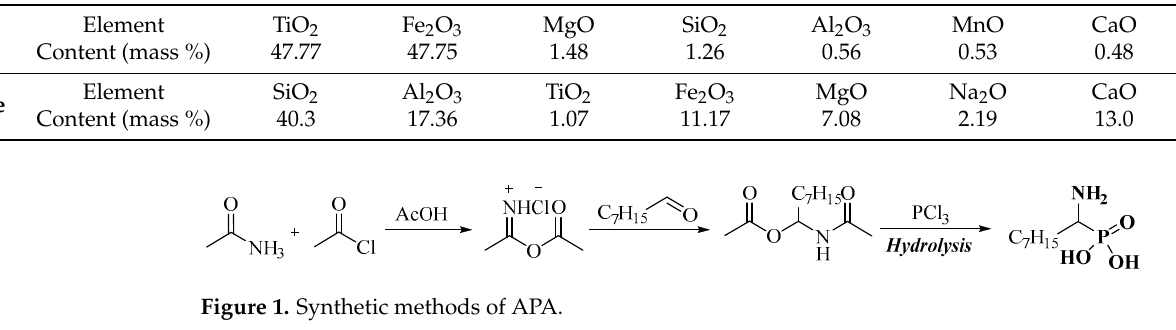
Table 2. Chemical composition of ilmenite sample.